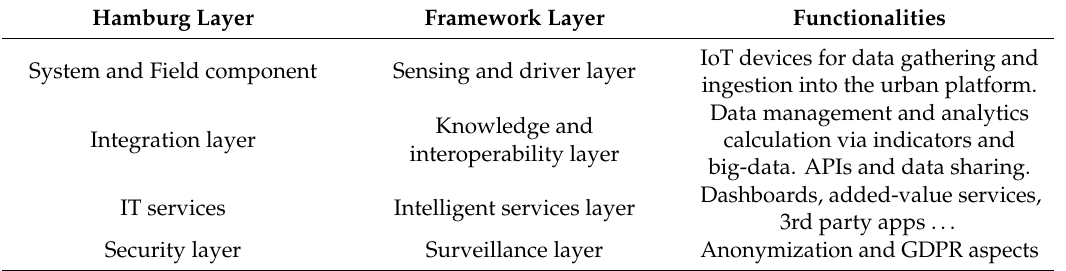
Table 2. Mapping the Open Specifications Framework and Hamburg Urban